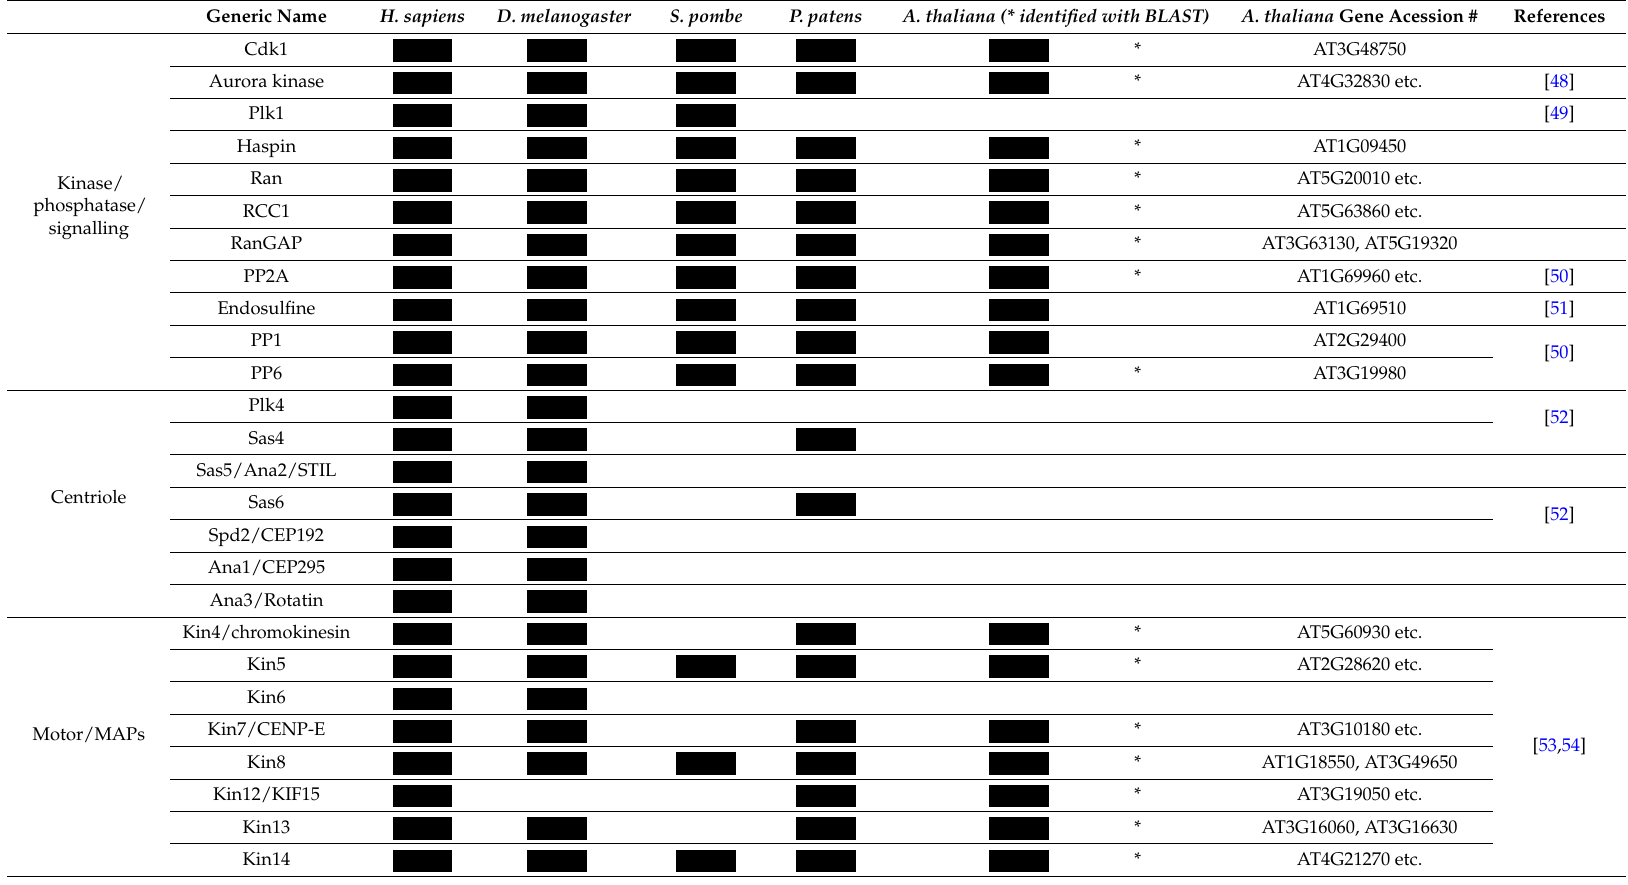
Table 1. List of homologues of spindle assembly